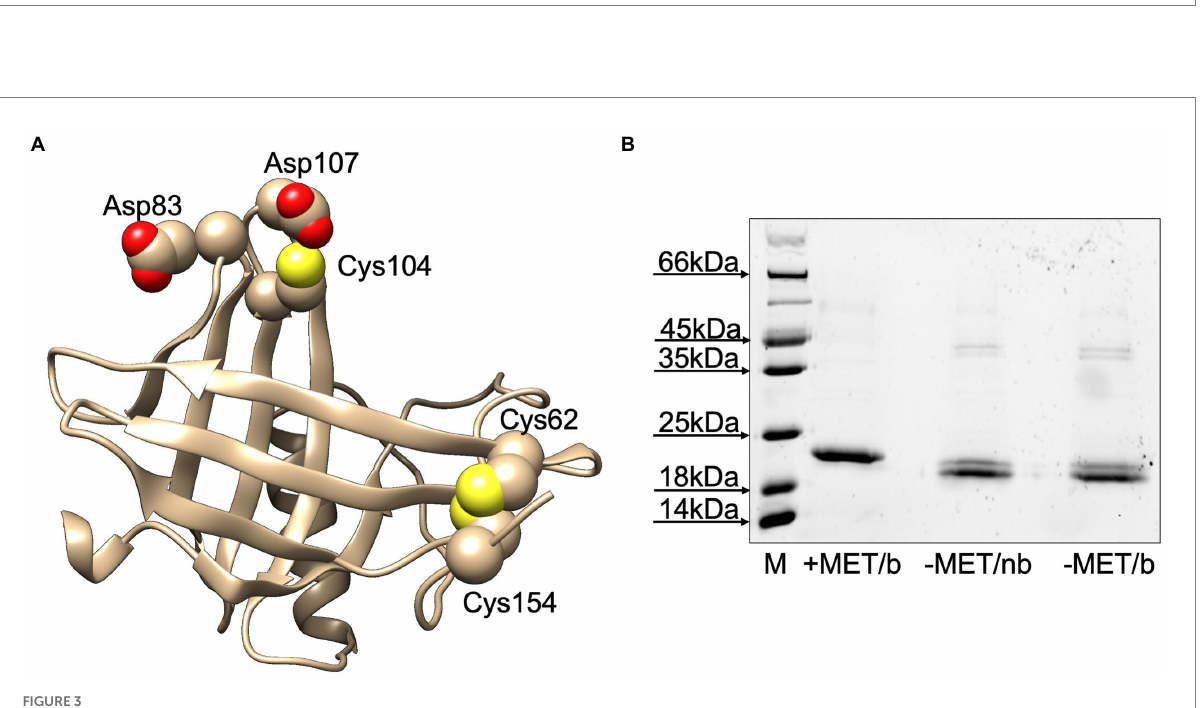
Figure 4C. The displacement curves of representative linear alcohols, fatty acids and esters are reported in